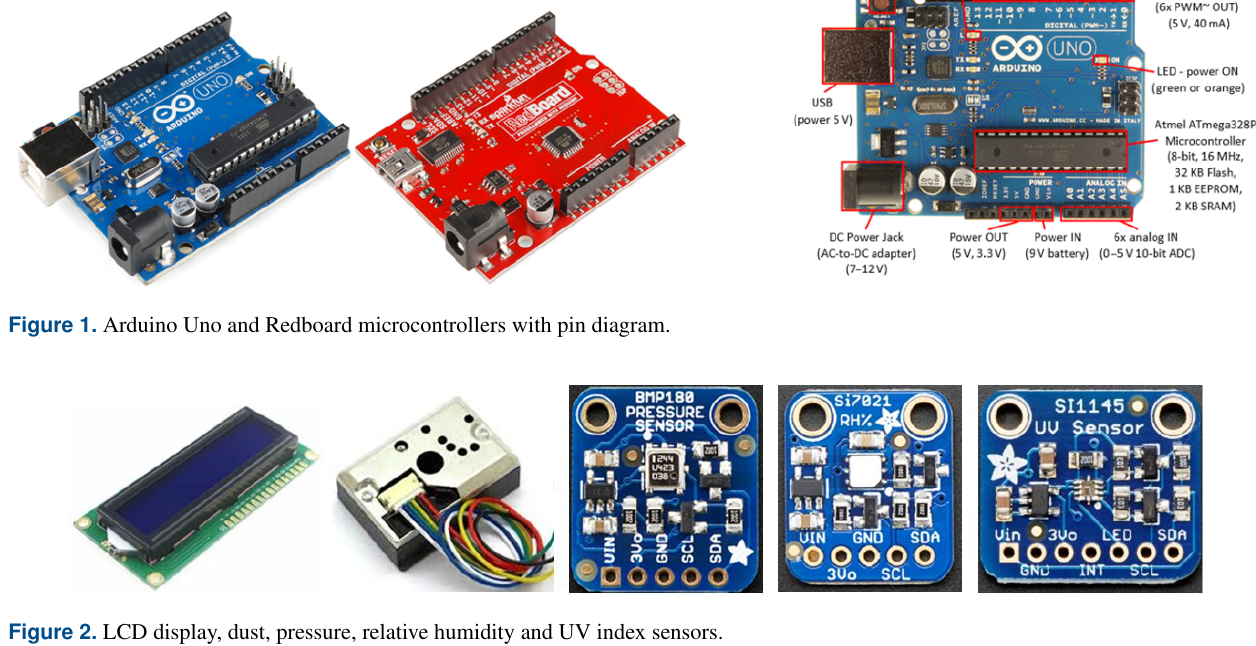
Figure 2. LCD display, dust, pressure, relative humidity and UV index